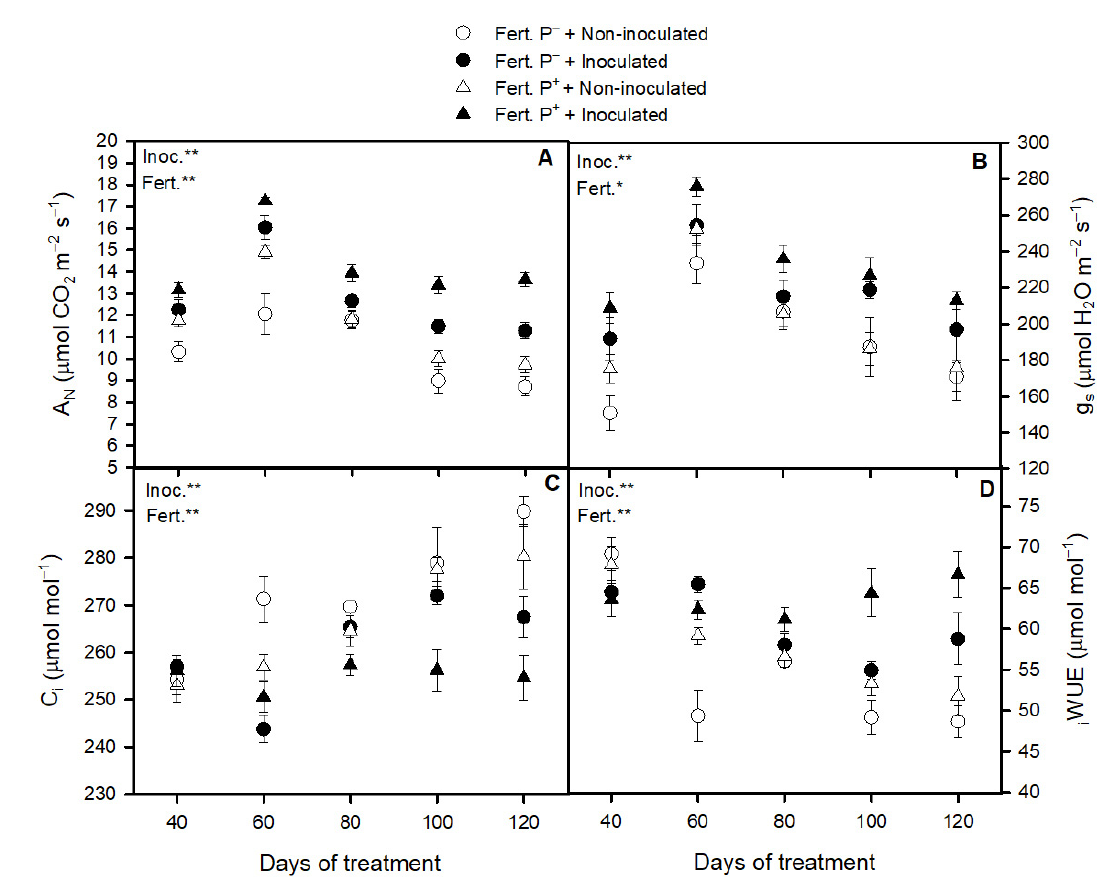
Figure 2. Net photosynthetic rate, A N ( A ), stomatal conductance, g s ( B ), intercellular CO 2 concentra- tion, C i ( C ), and intrinsic water use efficiency, i WUE (D) in strawberry plants fertilized with BNM medium without phosphorus (Fert. P − ) or with BNM medium supplemented with an insoluble phosphorus form (Fert. P+) and subjected to two inoculation treatments after 40, 60, 80, 100, and 120 days of treatment. Values represent mean ± SE of 10 replicates. For statistical details, see Figure 1 caption. (LSD test, * p < 0.05, ** p < 0.01).